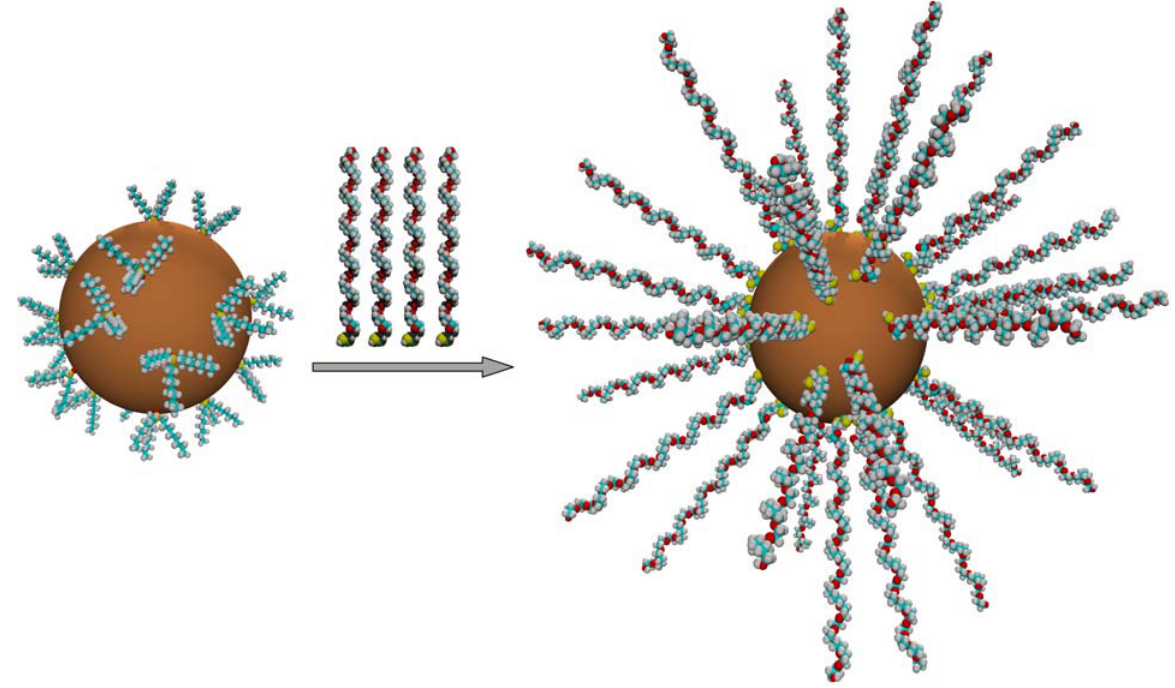
Figure 3. Cartoon schematic illustrating the process of ligand exchange. Organic ligands such as TOPO are exchanged for more desirable ligands such as those incorporating poly(ethylene glycol)